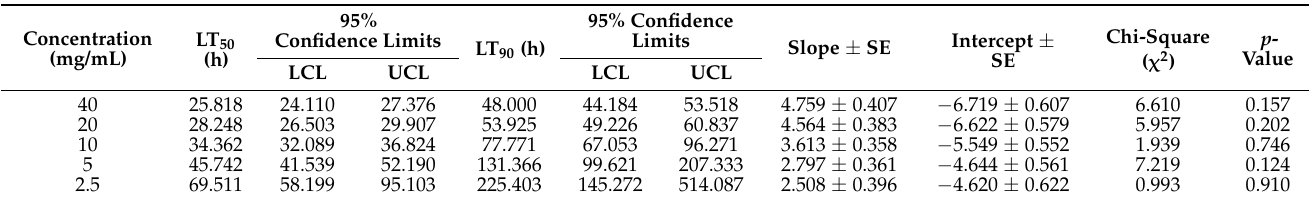
Table 3. The lethal time values for 50% and 90% mortality at various concentrations of Pinus roxburghii against R. ( B. ) microplus